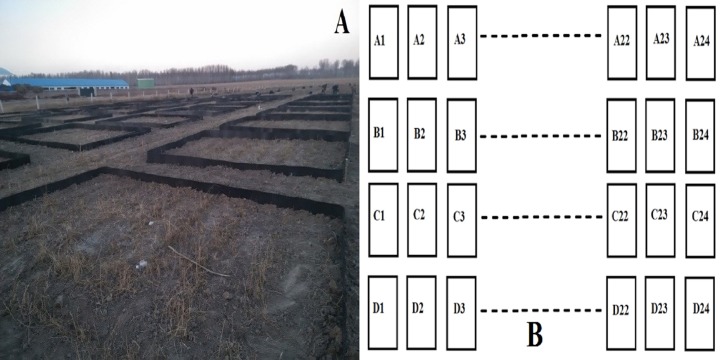
The distribution and area of experiment plots.(A) Distribution and area of the irrigation plots in this study; (B) the arrangement and total number of irrigation plots.